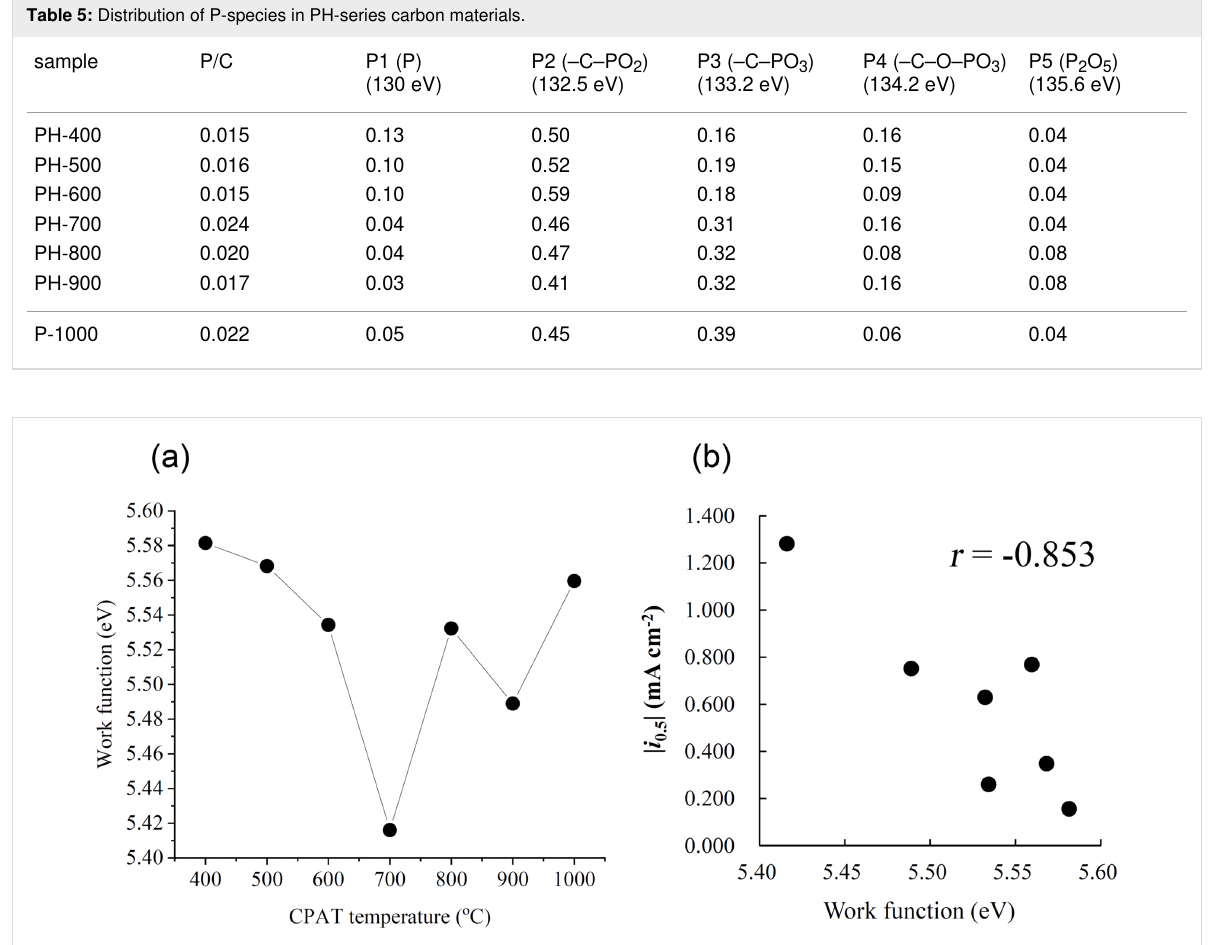
Figure 6: (a) Effect of CPAT temperature on the work function of PH-series carbon materials, (b) relationship between the ORR activity and the work function of carbonized samples.